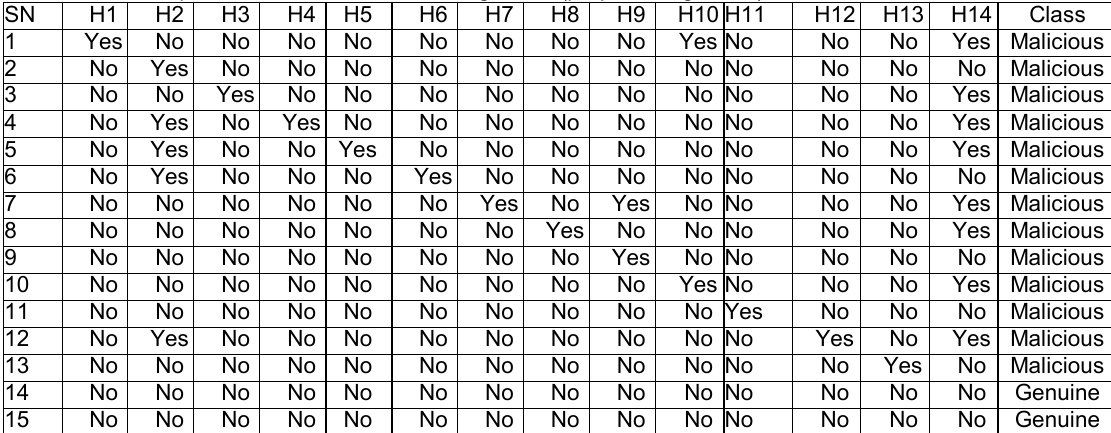
Table 2. Experimental Result of EMUD Algorithm (proposed algorithm)